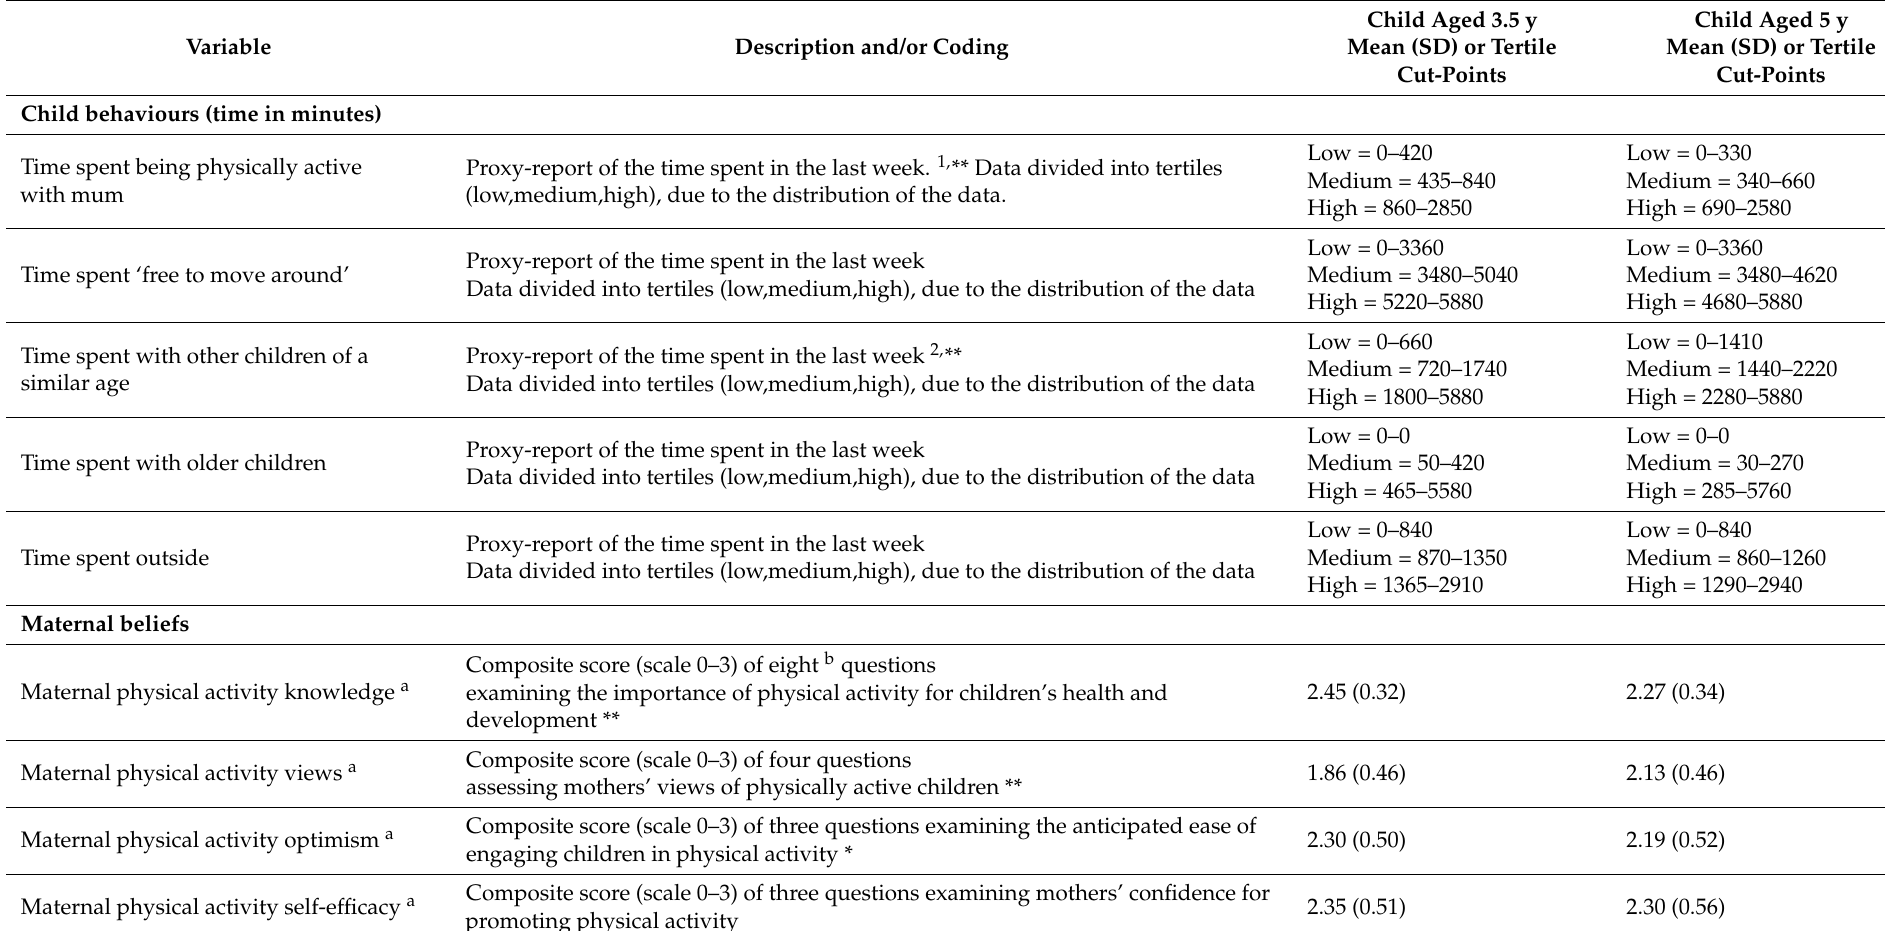
Table 2. Description of predictors included at 3.5 y and 5